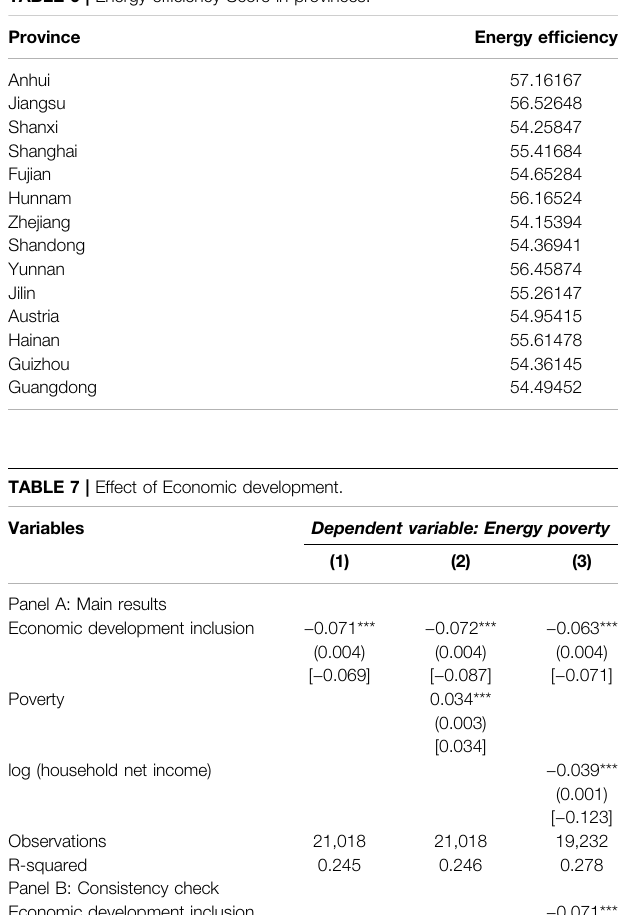
TABLE 6 | Energy ef fi ciency Score in provinces.